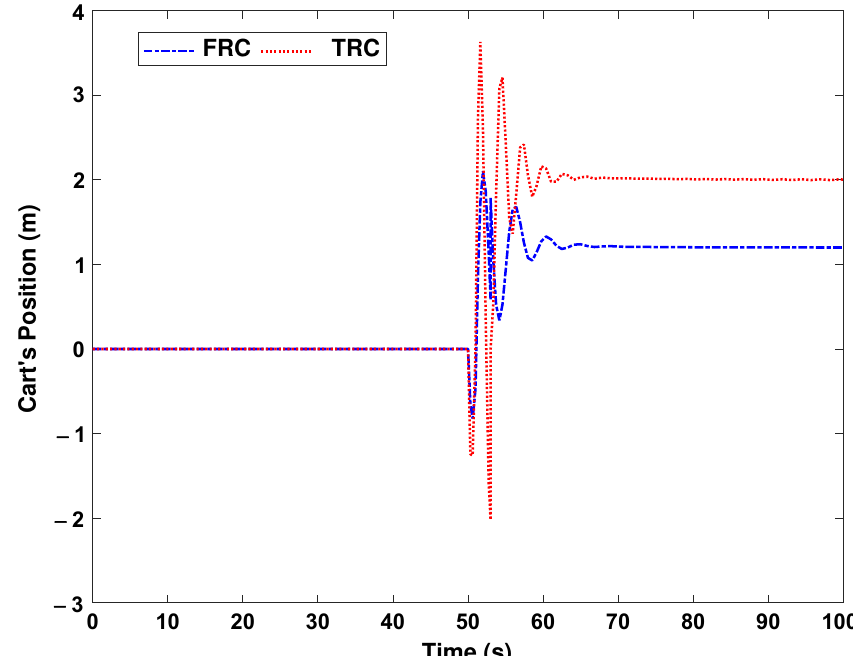
Figure 13. Position control of cart by FRC and TRC.